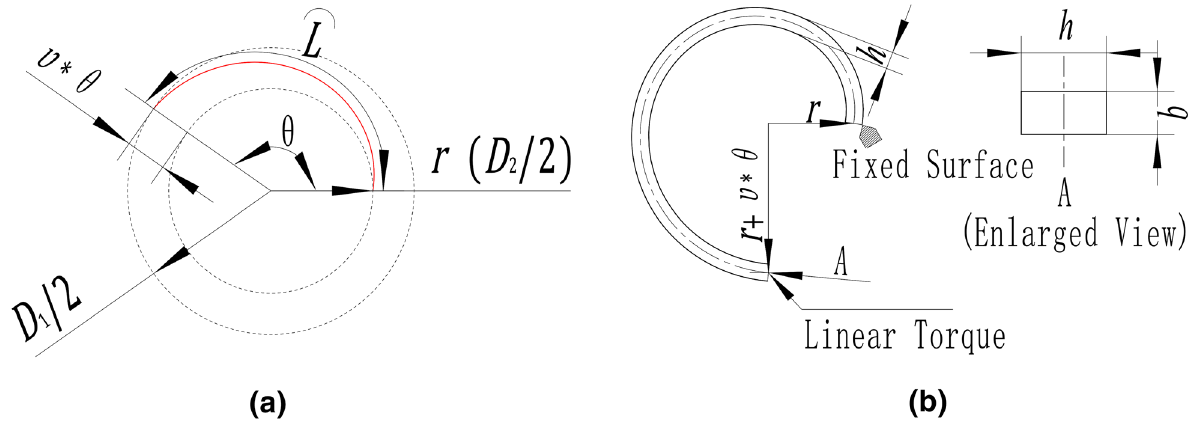
Figure 1. Parameters of spring arm and setting for